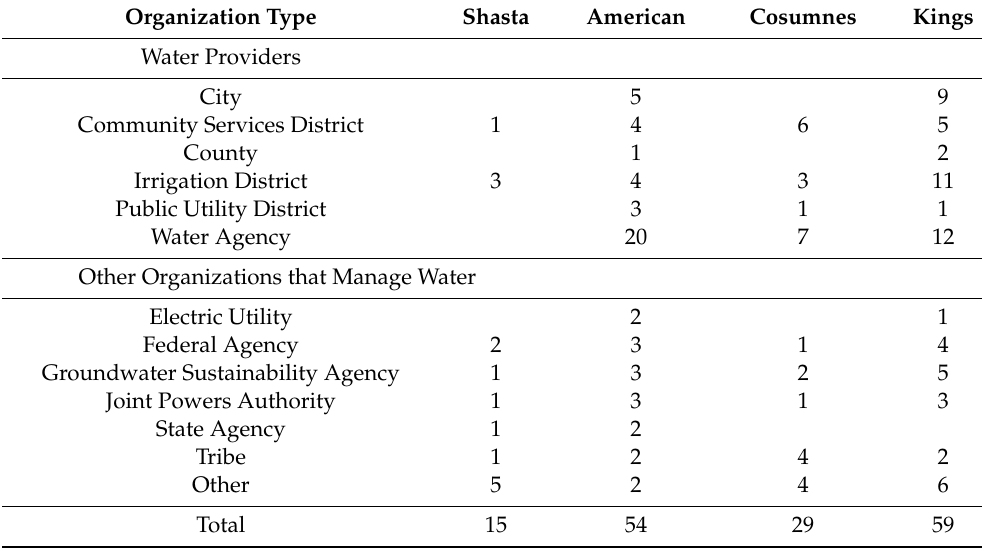
Table 3. Water management organizations by watershed.